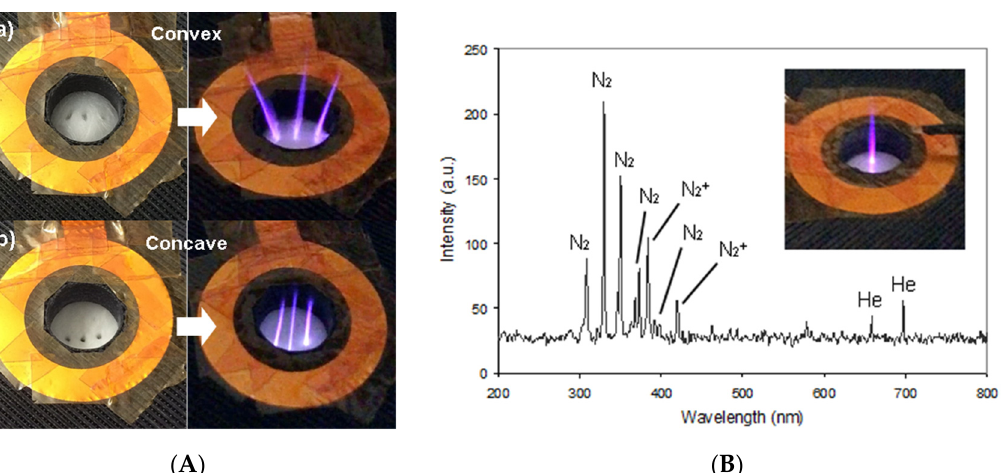
Figure 8. ( A ) Photographs of the aerogel flexible array emitting three APPJs in convex ( a ) and concave ( b ) bending modes. The large aperture, which is 1 cm in diameter, is surrounded by a ring Cu tape acting as ground. ( B ) OES spectrum collected from the flat 3-plasma jet shown in the inset image. Reprinted/adapted with permission from Ref. [44]. Copyright 2021, Authors.